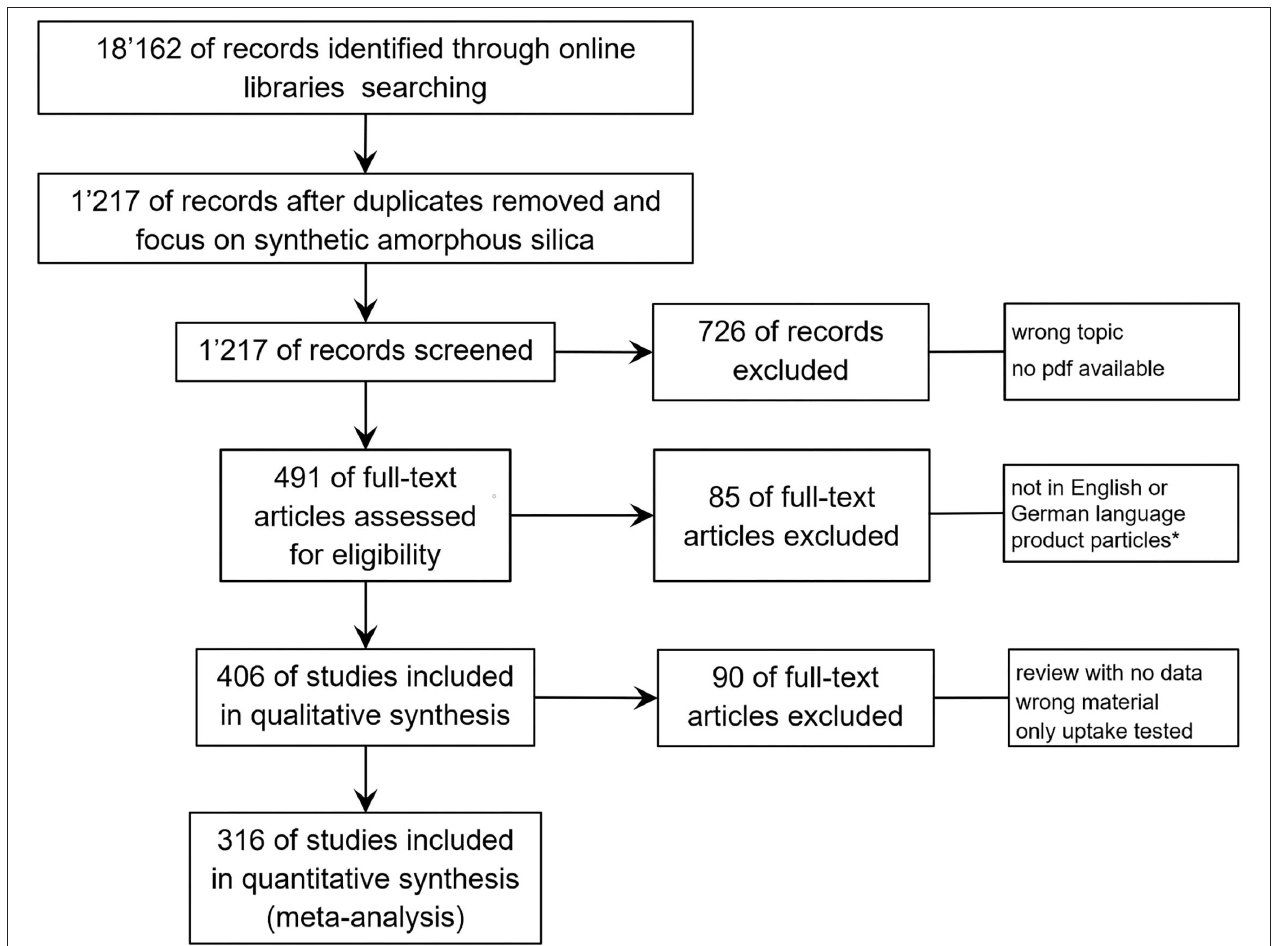
FIGURE 1 | PRISMA flow diagram demonstrating the process of systematic selection of relevant publications for synthetic amorphous silica (SAS) safety studies. Starting with 18,162 citations for the period 2013–2018 on nanotoxicology, 1,217 have been selected with the keyword “synthetic amorphous silica.” Evaluating these studies in more detail, the final database contains 316 publications that have been assessed for all study details. *Studies with particle mixtures from commercially available products tested, such as paints, have been